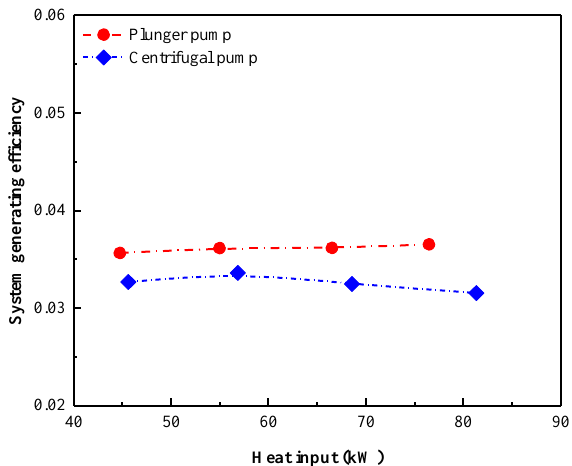
Figure 14. System generating efficiency with heat input using the plunger pump and centrifugal pump.